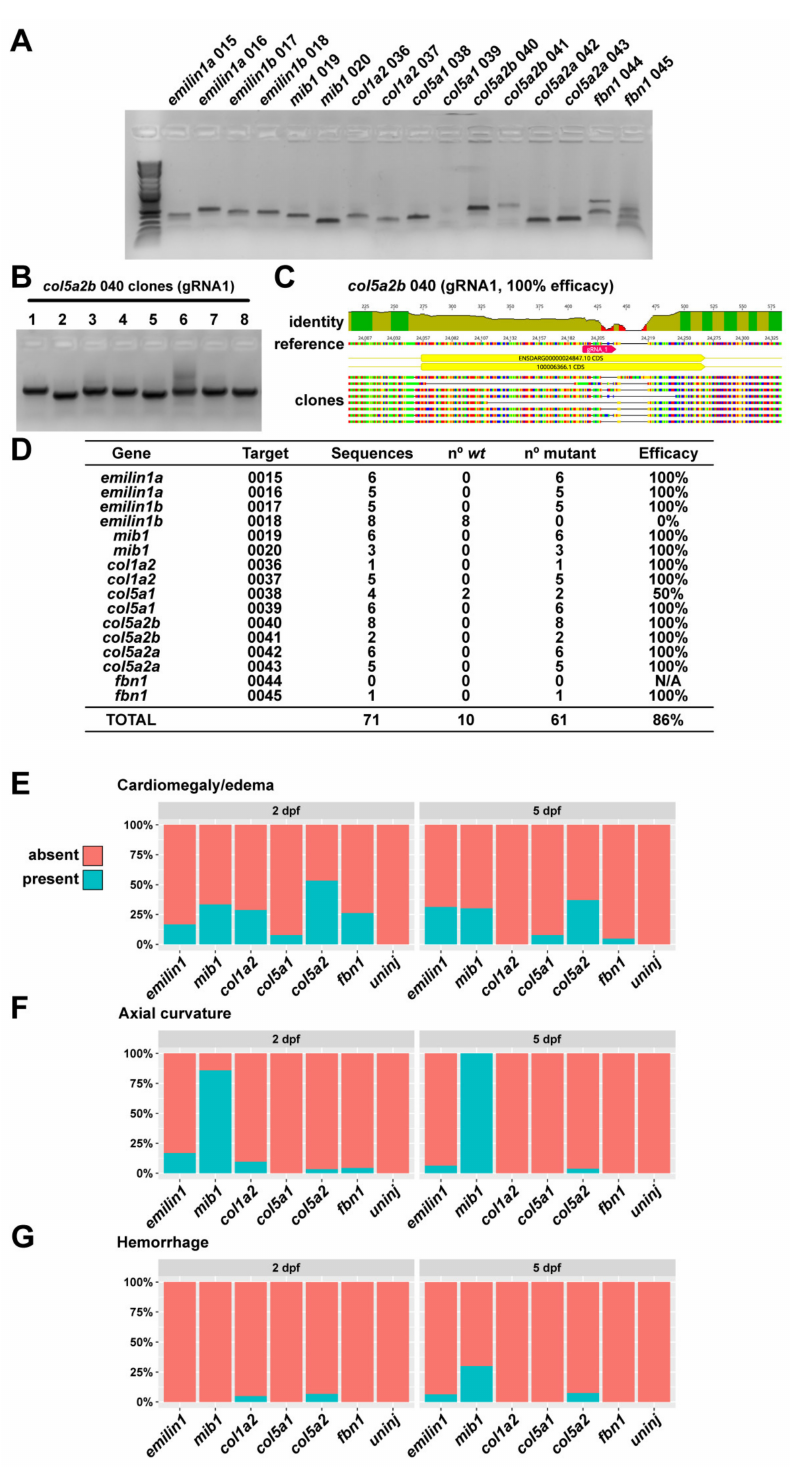
Figure 1. Quantification of phenotypes and gRNA efficacy. ( A ) Amplicons for each gRNA target were generated by PCR and then TOPO-cloned to generate a library of targeted genomic DNA sequences. ( B ) Individual clones were amplified by colony PCR and sent for sequencing. ( C ) Sequences were aligned to wt to determine the incidence of indel mutations. ( D ) For most targets, we are unable to isolate wt DNA by cloning, indicating a very high degree of mutational efficiency (with the exception of emilin1b gRNA 2, which appears to be non-functional). ( E ) Quantification of cardiomegaly phenotypes for all genes at 2 and 5 dpf. ( F ) Quantification of axial curvature defects for all genes at 2 and 5 dpf. ( G ) Quantification of hemorrhage defects for all genes at 2 and 5